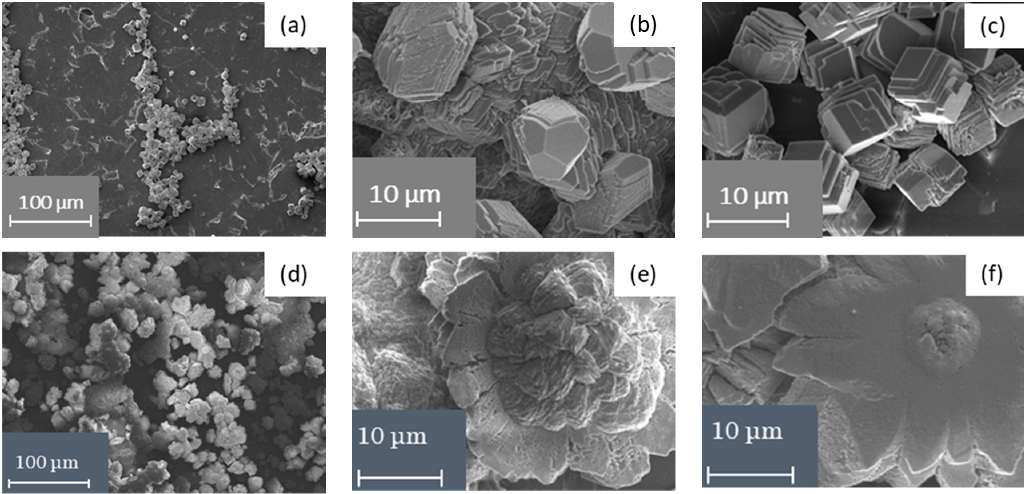
Figure 7. SEM images of the MK-40 ( a – c ) and MK-40 / PANI ( d – f ) membrane surfaces facing the desalination compartment after 5 h of electrodialysis of model solution at i = 1.4 i lim .